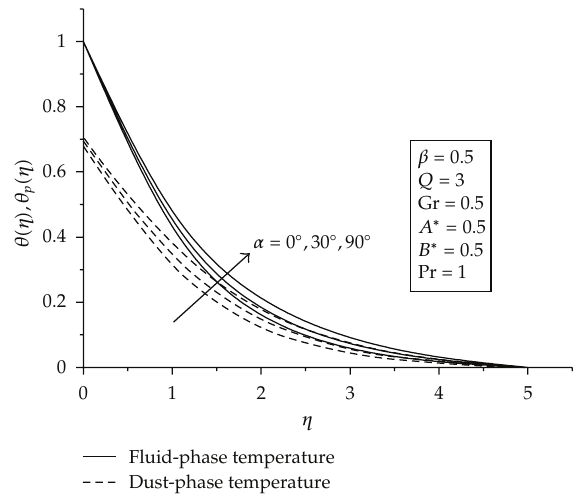
Figure 5: Temperature profile for di ff erent values of angle of